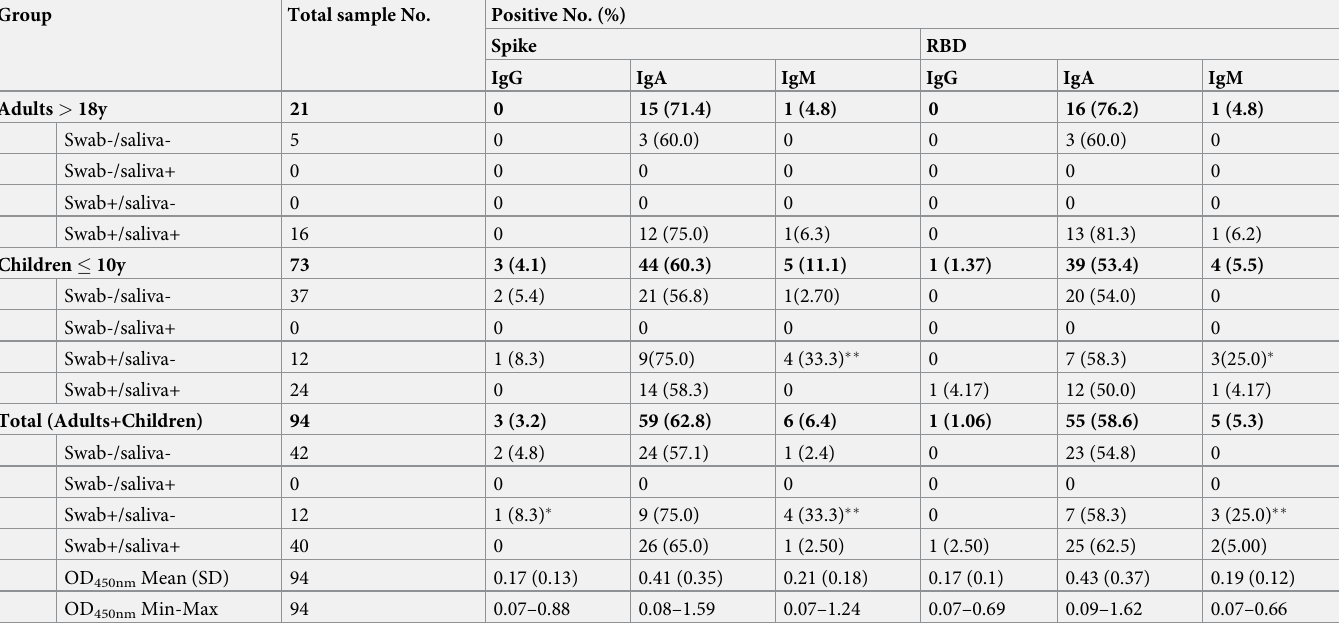
Table 3. Patients with antibodies in saliva against full-length spike or RBD, divided by age category and by RT-qPCR result on swab and saliva. Group Total sample No. Positive No. (%)